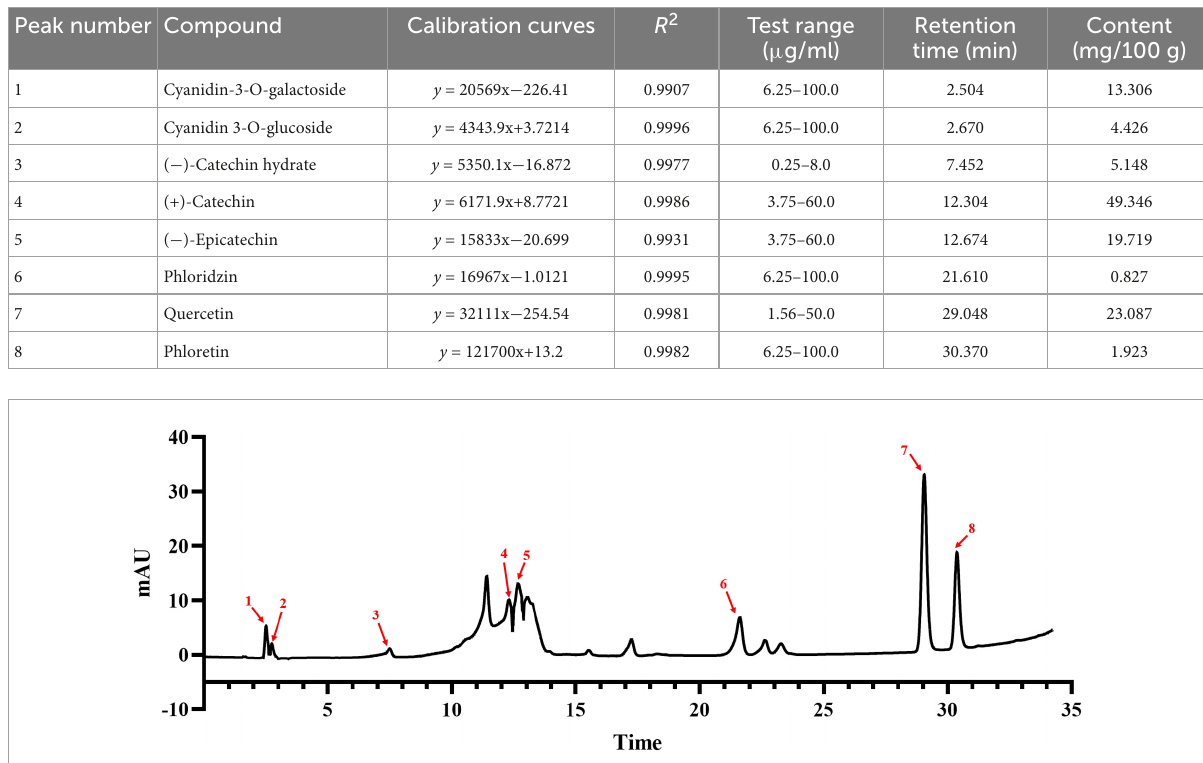
TABLE 1 Contents of flavonoids identified in RAFE and related HPLC data.